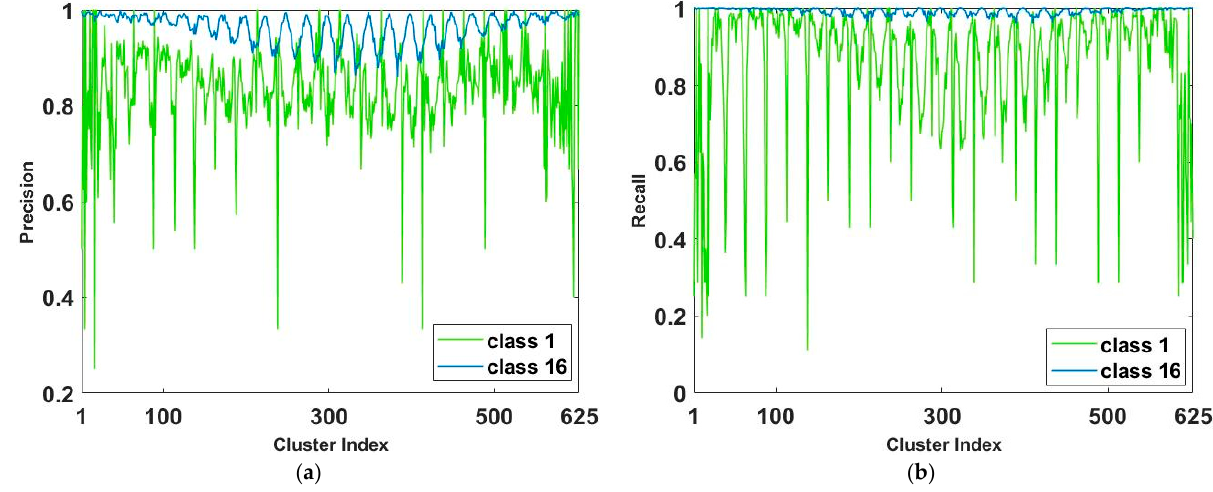
Figure 8. The plot of the ( a ) precision and ( b ) recall values of 625 CNN networks for class 1 and class 16.